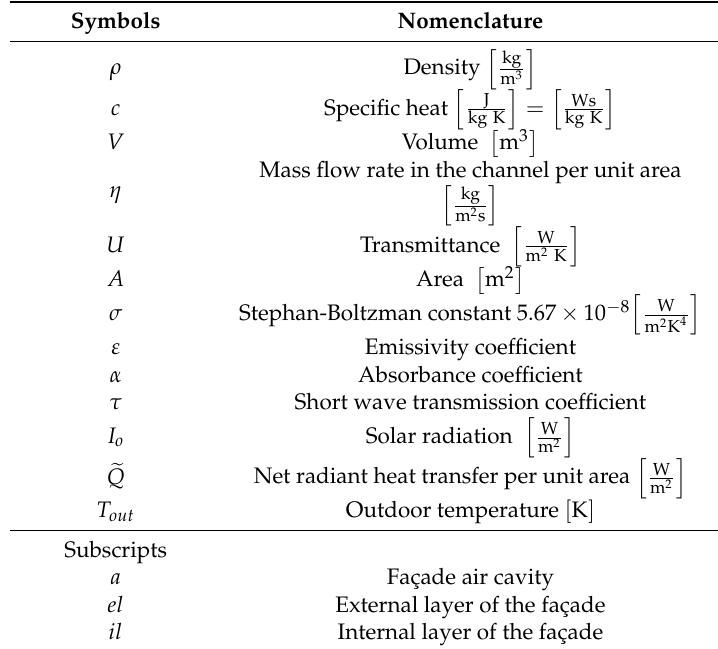
Table 1. Notation in problem (P façade